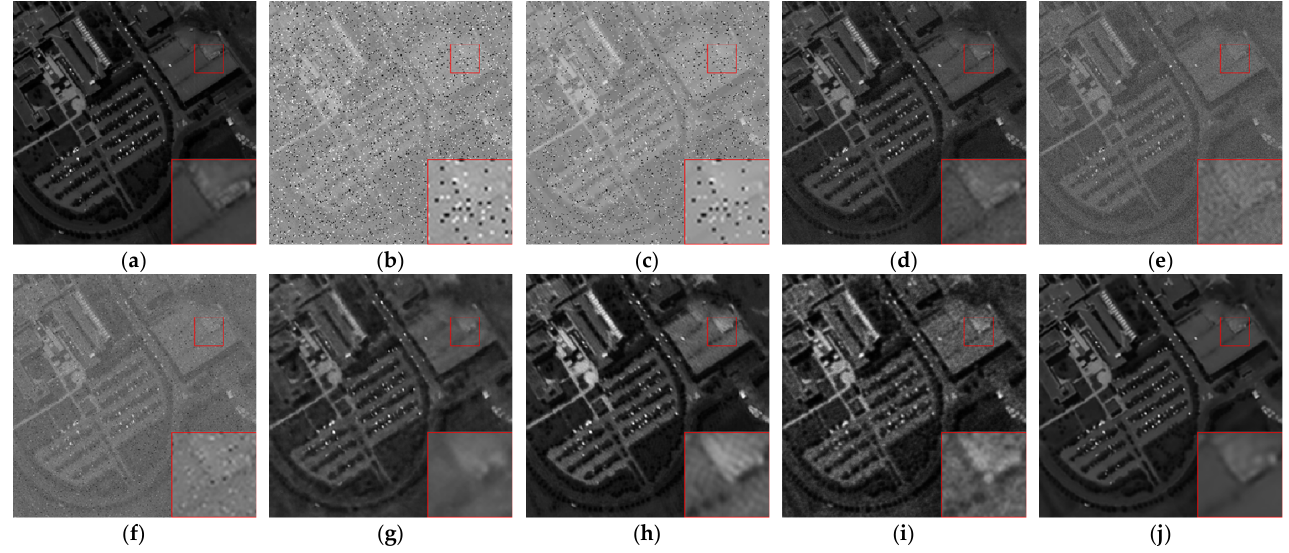
Figure 6. Case 3—Denoising results of different algorithms in band 26: ( a ) clean band; ( b ) noisy band; ( c ) BM4D; ( d ) LRMR; ( e ) HyRes; ( f ) L1HyMixDe; ( g ) DHP-2D; ( h ) SIP; ( i ) SURE-CNN; and ( j ) 3S-HSID.